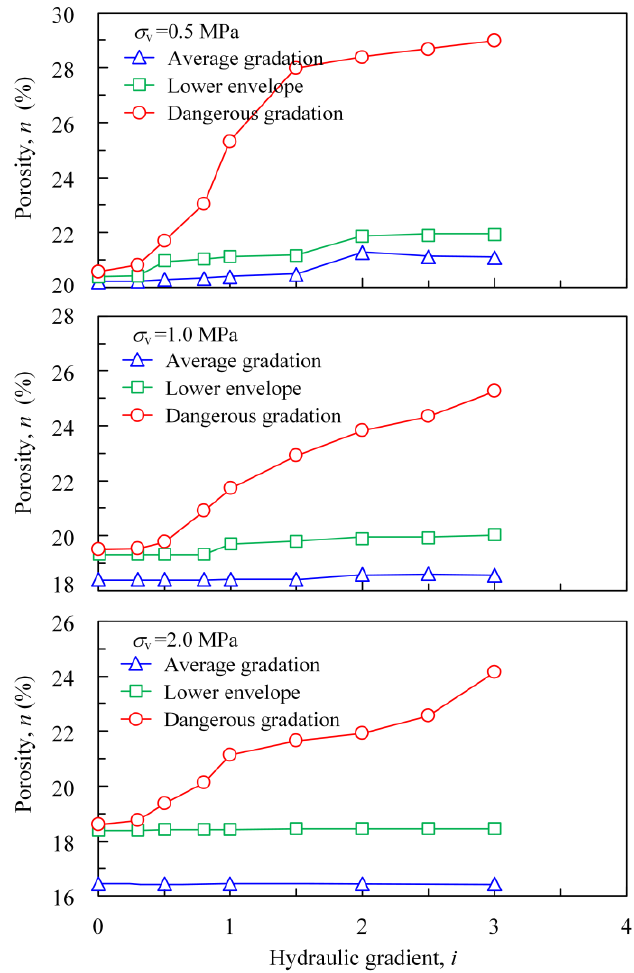
Figure 10. Porosity versus hydraulic gradient.